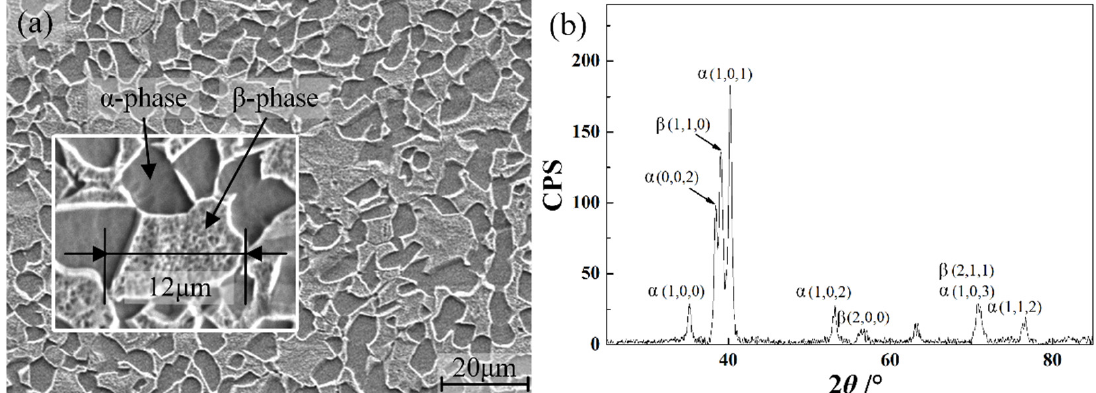
Figure 1. Microstructure of dual-phase titanium alloy: ( a ) SEM; ( b ) XRD.